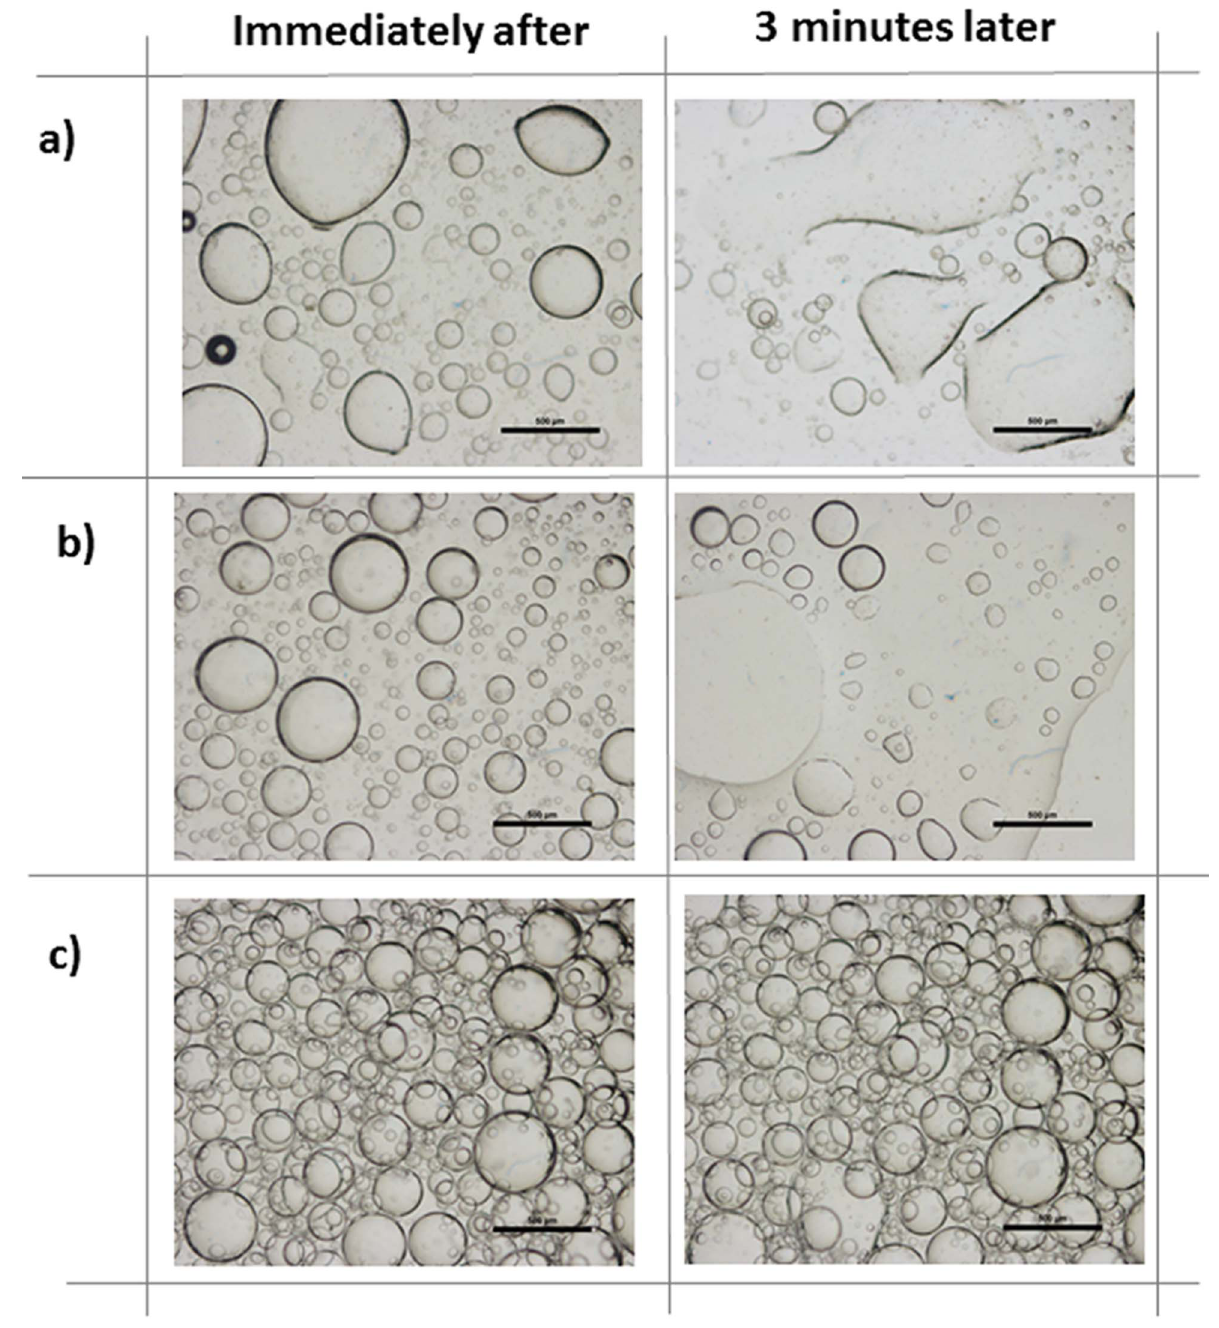
Figure 2. Optical microscope images of wet emulsions with internal volume fraction Q =25% (v/v) prepared by different stabilization methods for immediately after and 3 minutes after preparation of emulsions. (a) Wet emulsions without stabilizing agent, (b) wet emulsions prepared with SDS surfactant as the stabilizing agent, (c) wet emulsions prepared by nanoparticle stabilization. Scale bar is 500 m m.